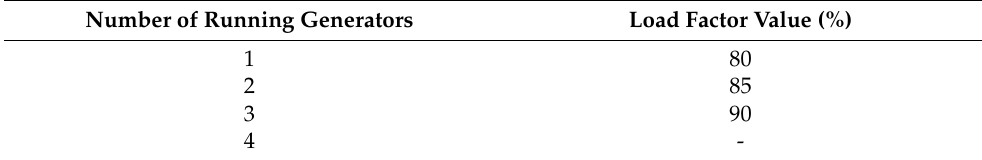
Table 2. Parameters of the heavy load algorithm.